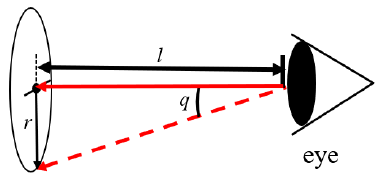
Figure 4. Errors caused by microsaccades.